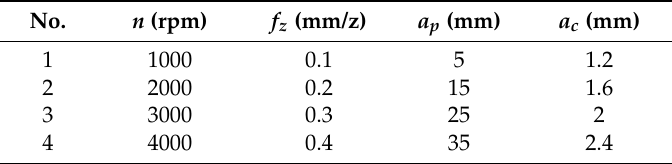
Table 1. Control factors and their levels of rough milling process.